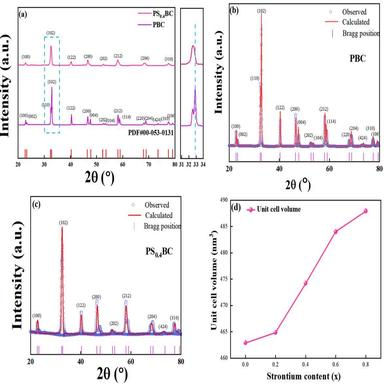
(a) XRD patterns of the PBC and PS0.4BC powders sintered at 1050 ◦C for 10 h; (b–c) Rietveld refinement analysis results of the PBC and PS0.4BC samples; (d) The curve of the cell parameters of the PBC and PS0.4BC samples.